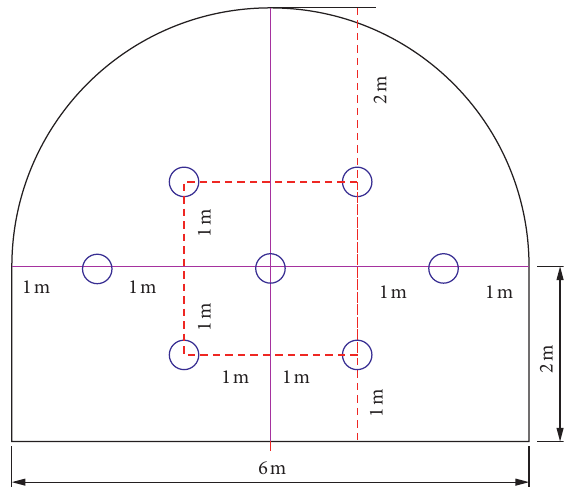
Figure 6: Layout of pressure relief